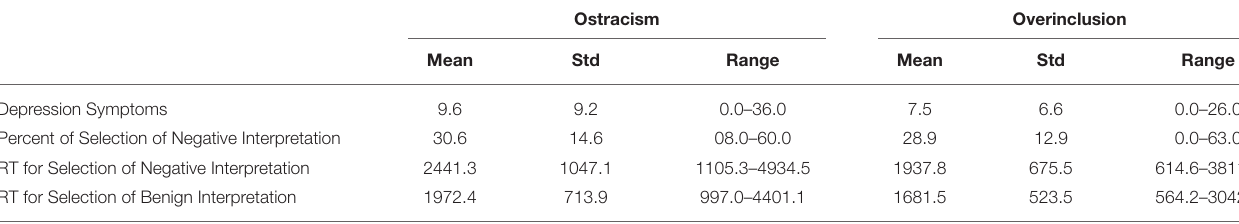
TABLE 1 | Descriptive statistics of depression symptoms and interpretation, by condition